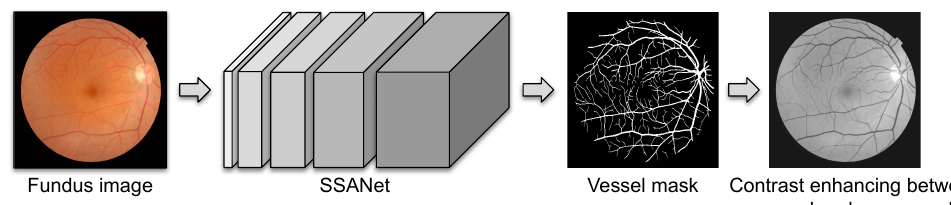
Figure 4. Visual description of the proposed preprocessing scheme based on vessel segmentation using the SSANet of [19].